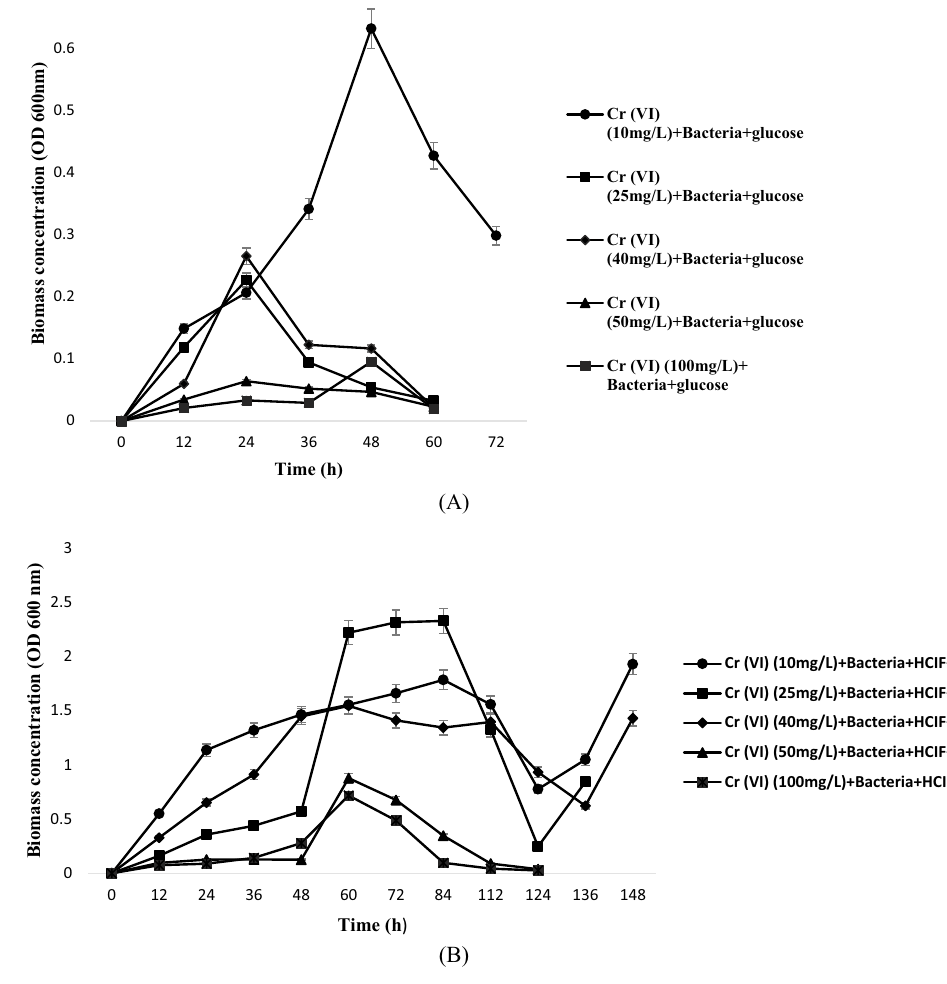
Figure 1. Temporal variation in biomass concentration with the ( A ) binary substrate system ( B ) tertiary substrate